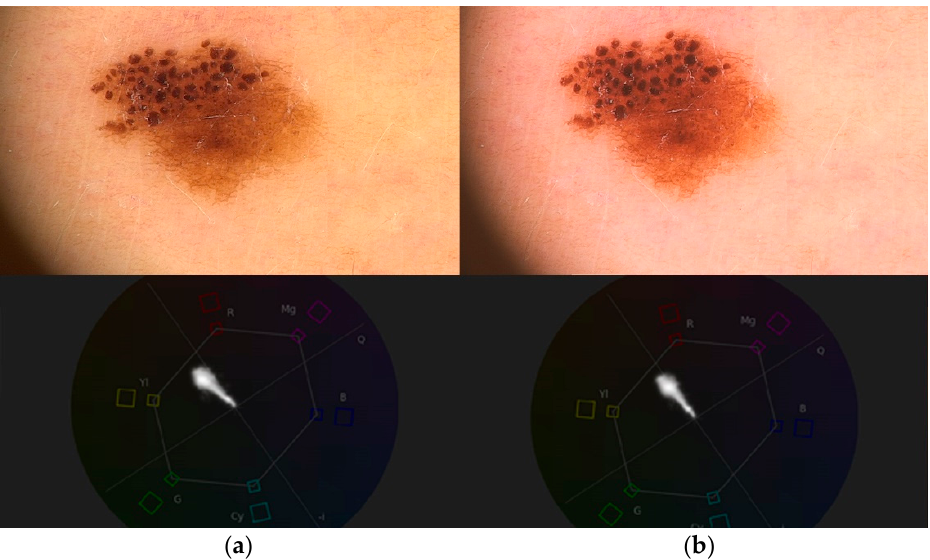
Figure 10. Colours are presented in the vectorscope as dots. ( a ) Dots are aligned on the “skin tone line” presenting the reference value of the skin tone colours, and ( b ) dots presenting colours in the image if the reference colours were captured on the Medicam 1000s camera.